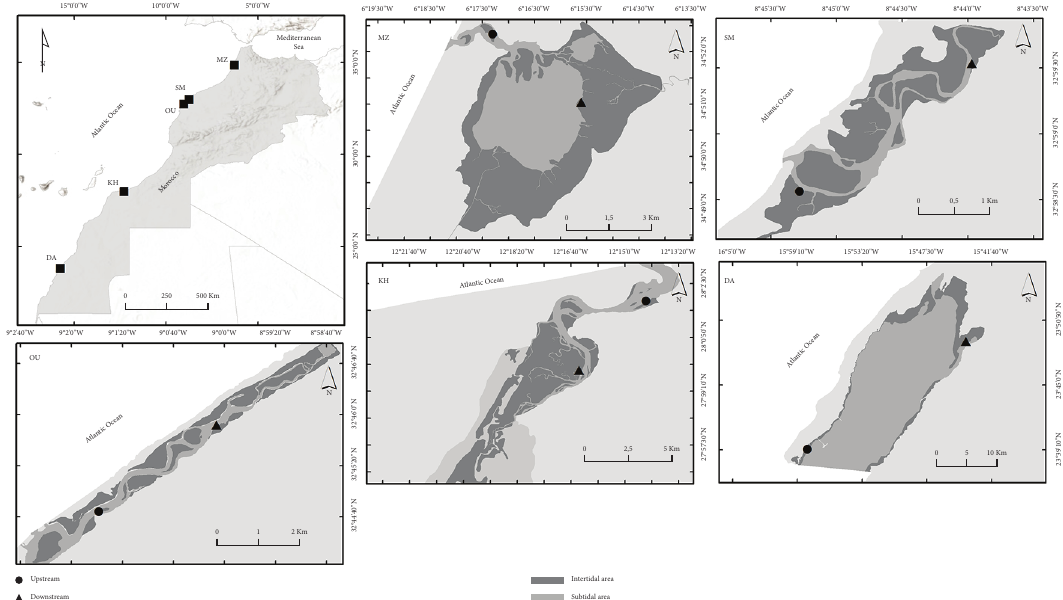
Figure 1: Map showing the location of the study sites across the Atlantic coast of Morocco. MZ : Merja Zerga lagoon; SM : Sidi Moussa lagoon; OU : Oualidia lagoon, KH : Khnifiss lagoon, and DA : Dakhla